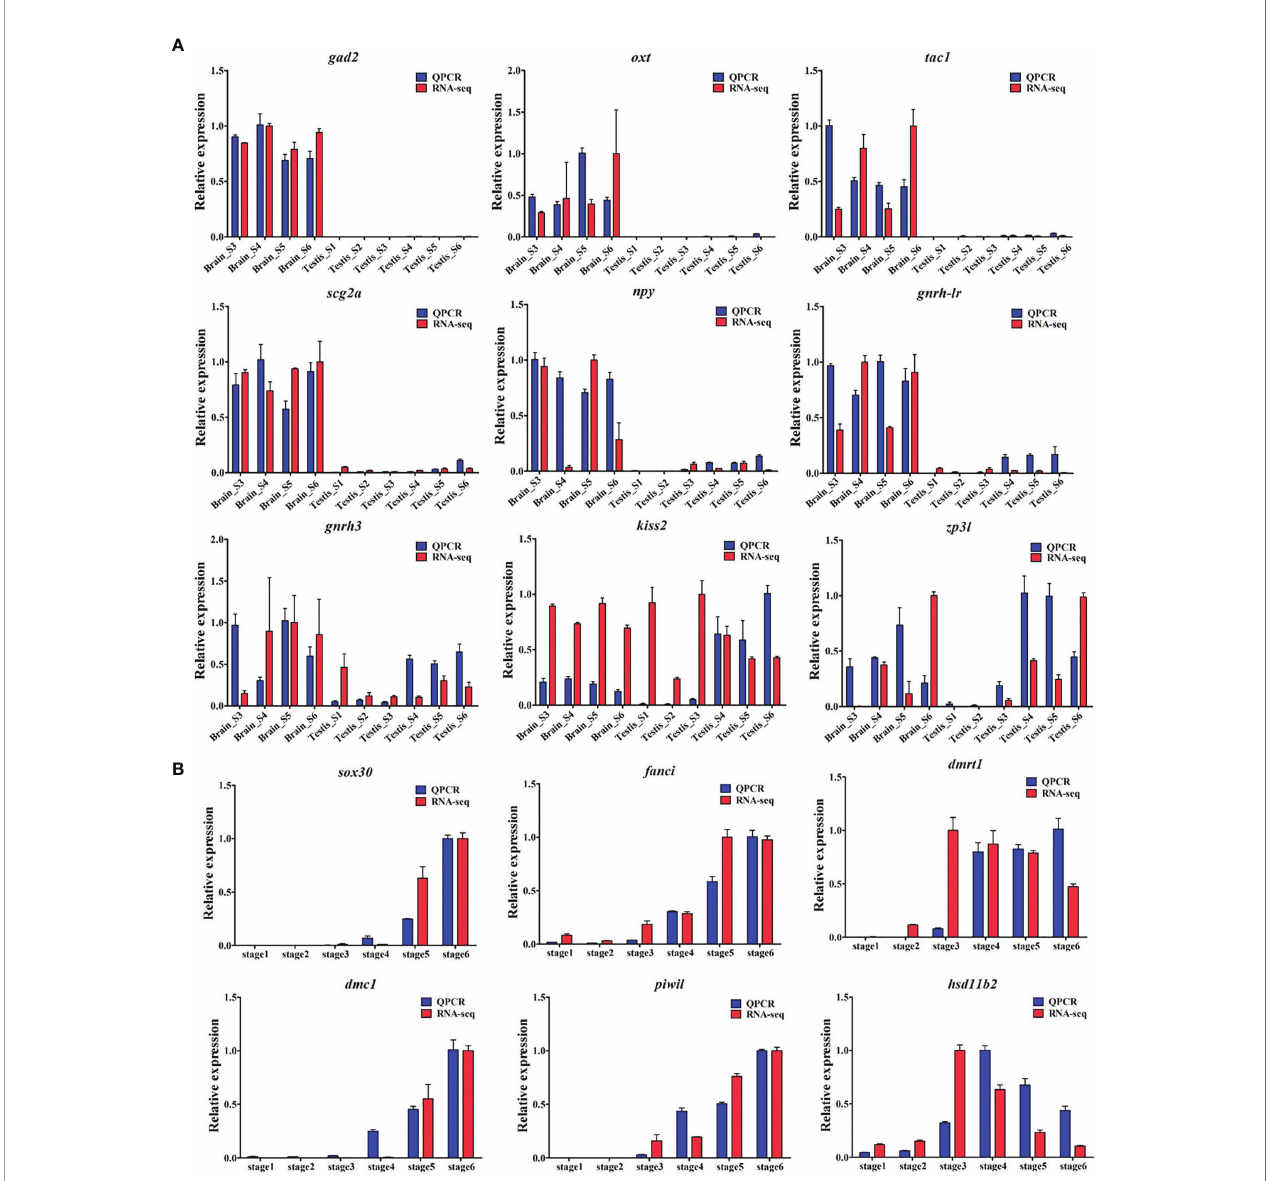
FIGURE 8 | Validation of RNA-seq data using qRT-PCR. In total, expressions of 15 genes were detected by RNA-seq (red column) and qRT-PCR (blue column). (A) The expressions of gad2 , oxt , tac1 , scg2a , npy , ghrh-lr , gnrh3 , kiss2 , and zp3l genes in the brain and testes at different stages during gonadogenesis in common carp. (B) The expressions of sox30 , fanci , dmrt1 , dmc1 , piwil , and hsd11b2 genes in the testis across gonad